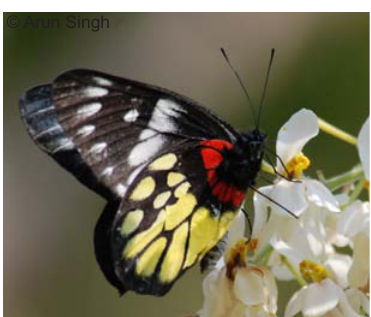
Image 22. Red-Base Jezebel Delias